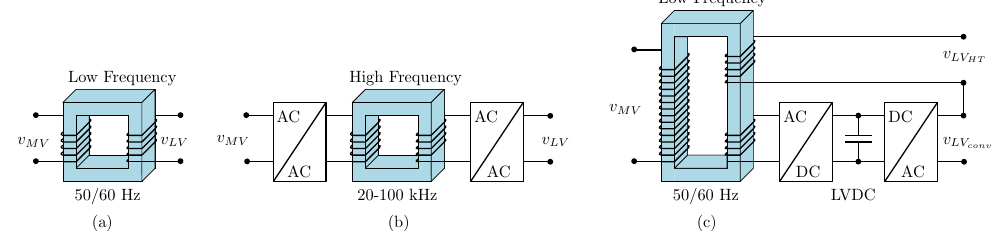
Figure 5. Different types of transformers: ( a ) LFT; ( b ) SST; ( c )